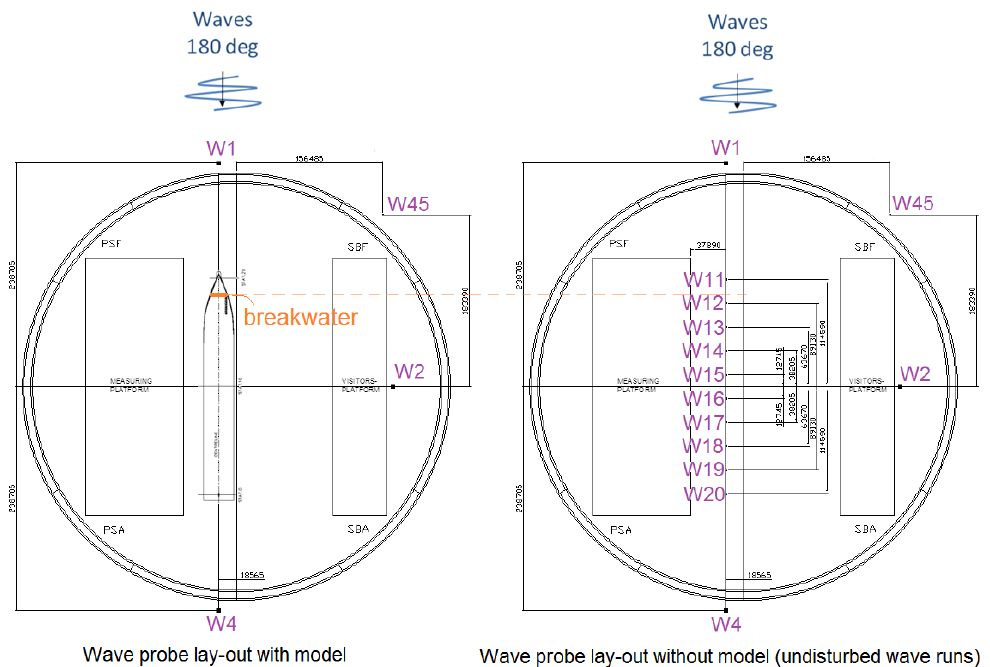
Figure 3. Wave probe layout under the (circular) carriage with and without model, moving with a fixed speed against the 180 deg waves (where W# = wave probe